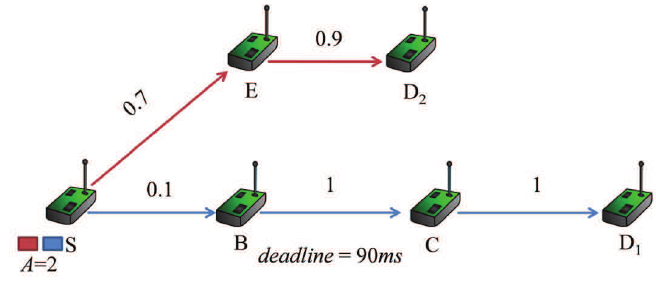
Figure 1. Impact of the retransmission threshold on the probability of packet